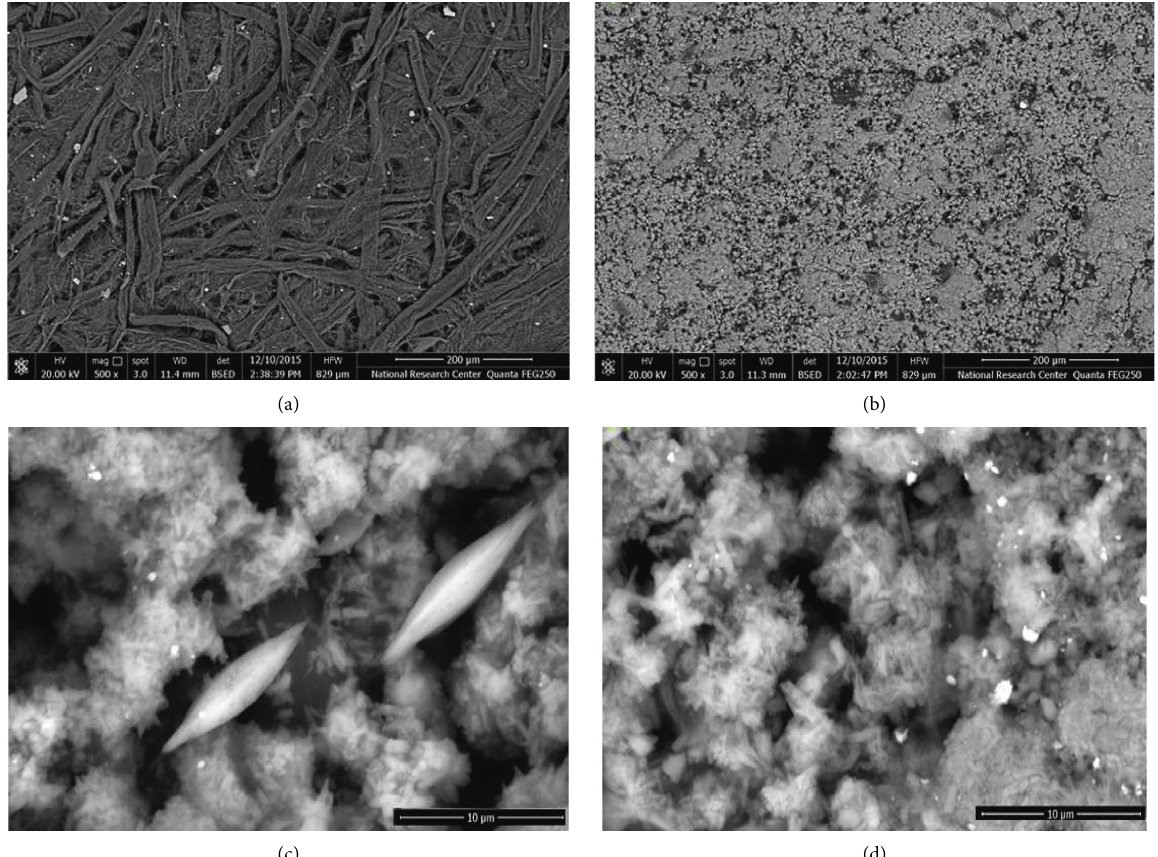
Figure 10: The shape of the blue stamp fiber paper, which shows that it is made of cotton pulp at a magnification of 500X (a). Printing ink granules with cracking in the color layer and growth of fungi at 500X magnification (b). (c) Amount of stamp fibers frayed using SEM (12000X magnification). The effect of fungal growth on the erosion of the fibers of the stamp paper (12000X magnification)